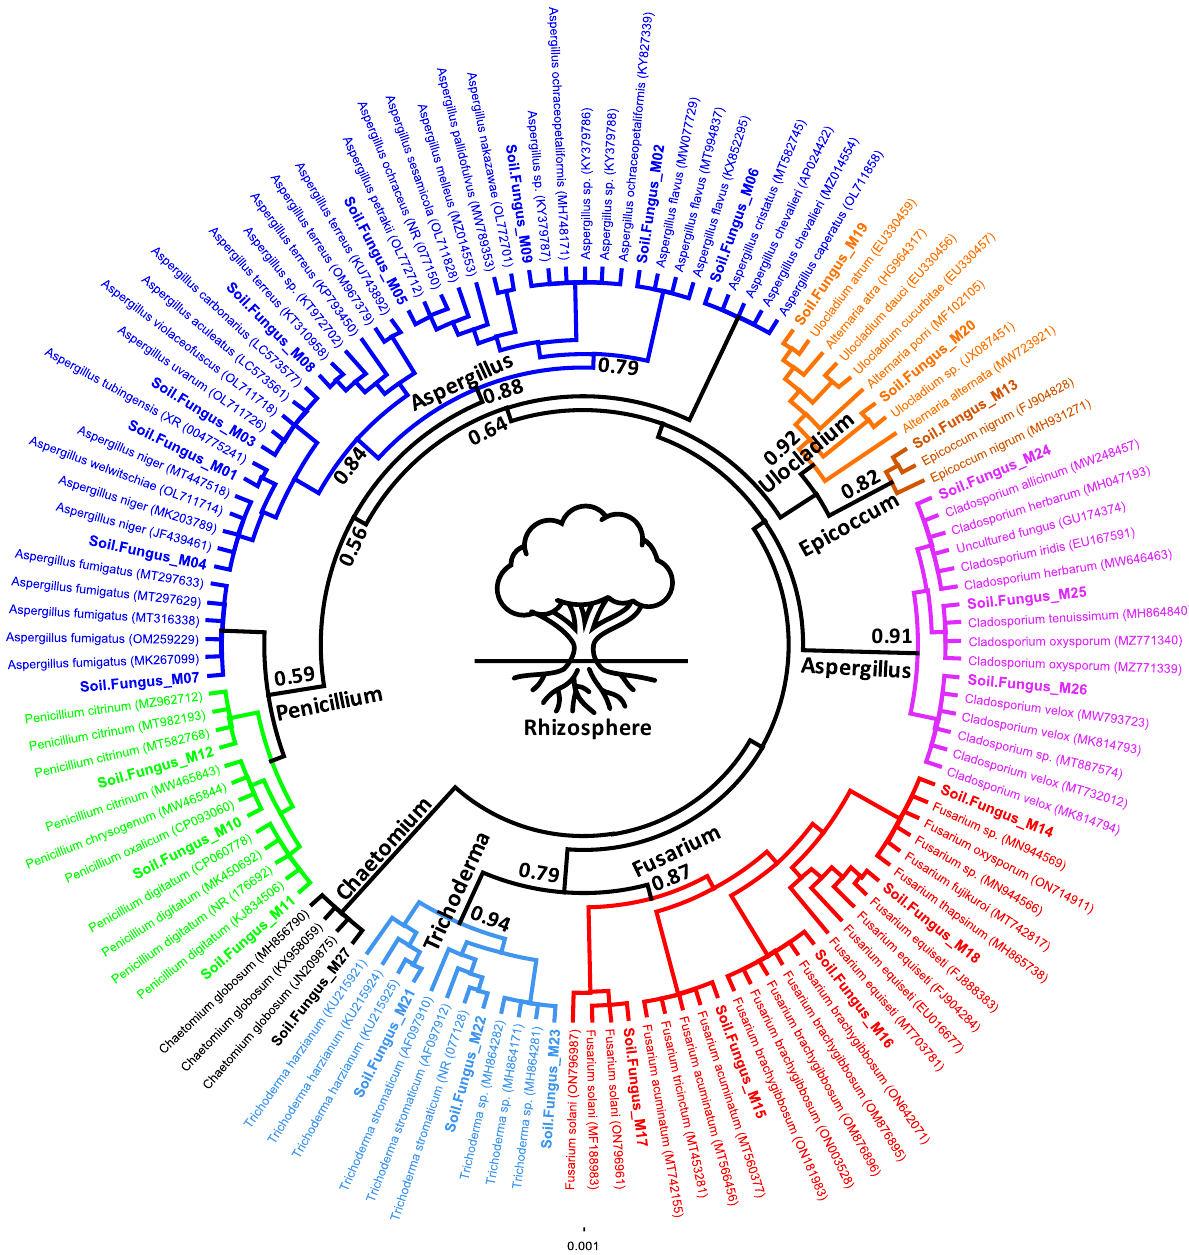
Figure 4. The phylogenetic tree for the fungal isolates species from the current study includes similar internal transcribed spacer data recorded for each species in the NCBI database. Different clusters were named by genus name, and samples were coded as “Soil.Fungus_M#” and serialized by number in the same order as Table 3.